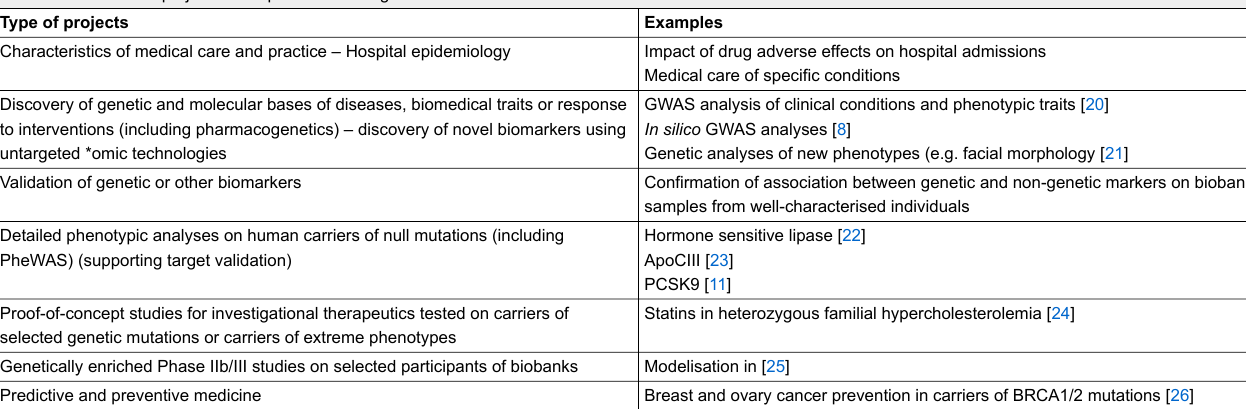
Table 2: Potential for projects to be performed using the BIL bio-resource. Type of